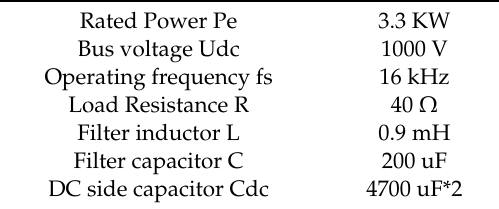
Table 3. Experiment platform parameters.